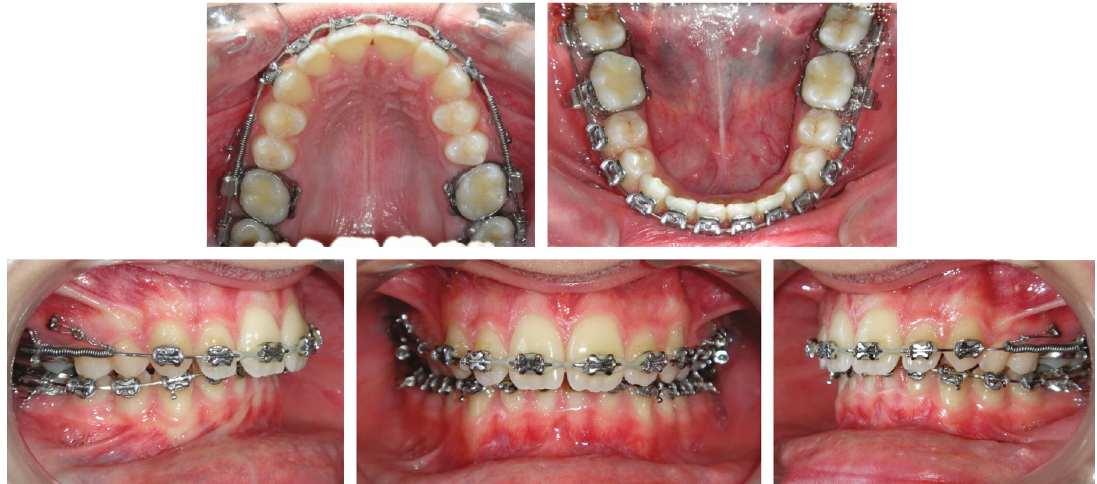
Figure 12: Case 2. Simultaneous distalization of maxillary fi rst and second molars.